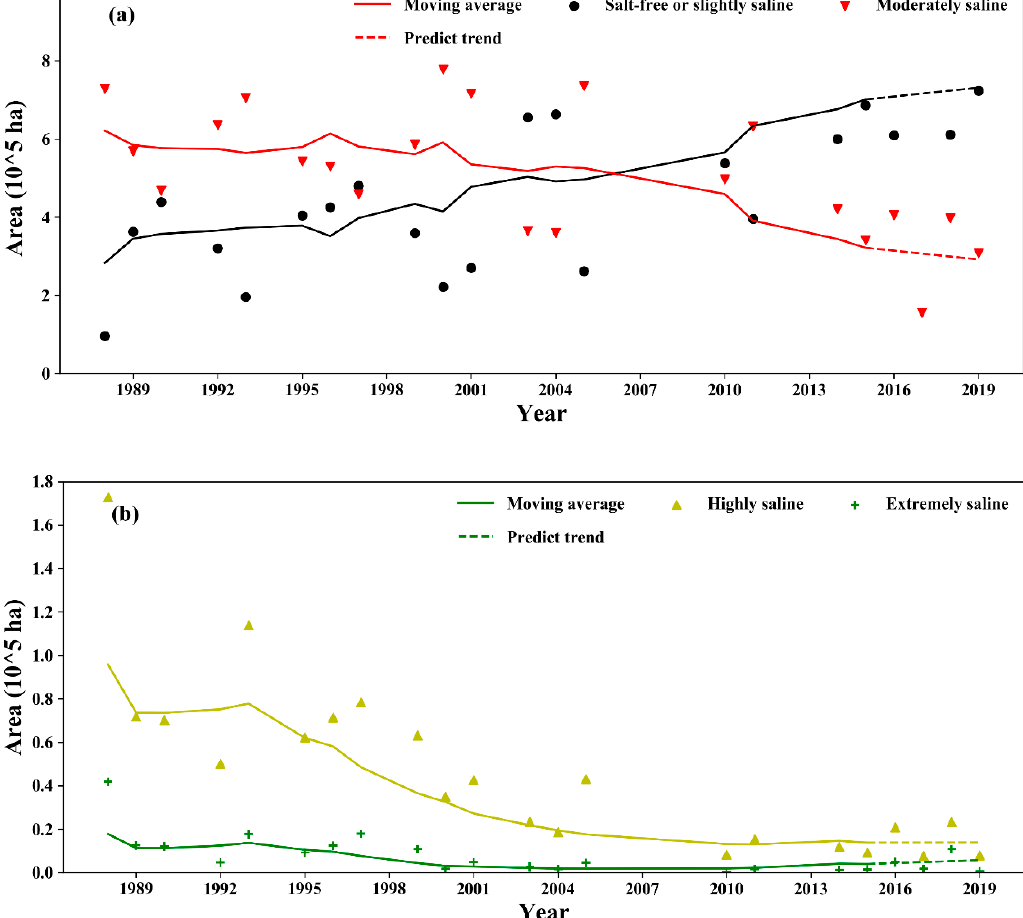
Figure 10. The dynamics of desalinization in Hetao: ( a ) salt-free/slightly saline and moderately saline; ( b ) highly saline and extremely saline. The area for each year was statistically analyzed using mono-temporal SI data from March or April when the study area was uncropped. The trends are depicted by moving average data with a window of 5.